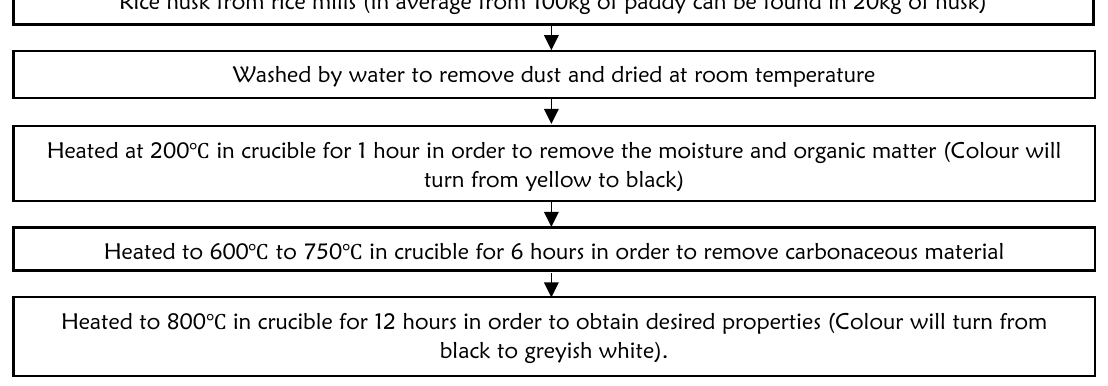
Figure 5: Flow chart representing the process of making rice husk ash